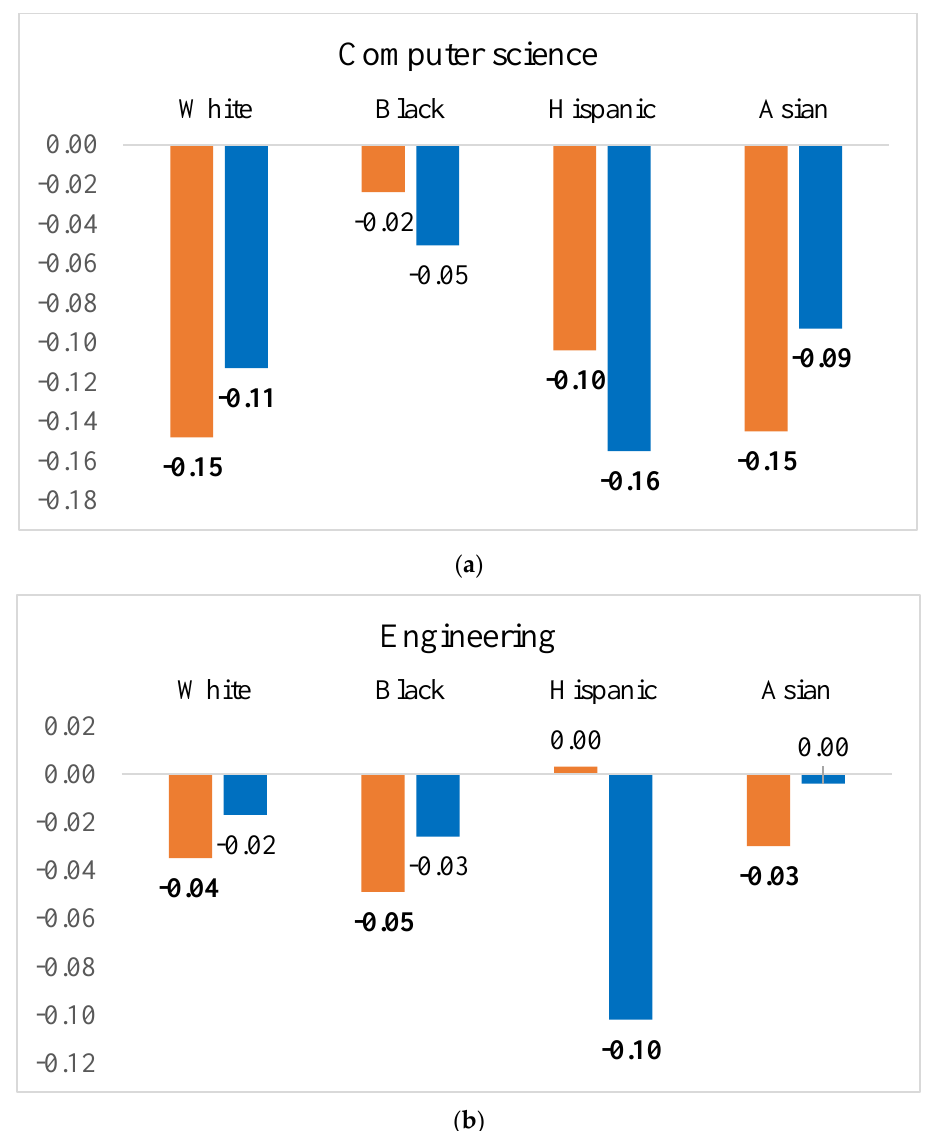
Figure 3. Differences in likelihood of working in STEM for women relative to men by race, coefficient on indicator for women from LPM regressions predicting likelihood of working in STEM, separate regressions by race/ethnic group and STEM major. (a) Computer Science Majors; (b) Engineering Majors. Source: National Science Foundation’s Scientists and Engineers Statistical Data System (SESTAT) 1995–2008. All men and women graduating with a bachelor’s degree in computer science or engineering between 1970 and 2004, and employed at the time of survey. Bolded coefficients indicate statistically significant at p < 0.05 level.